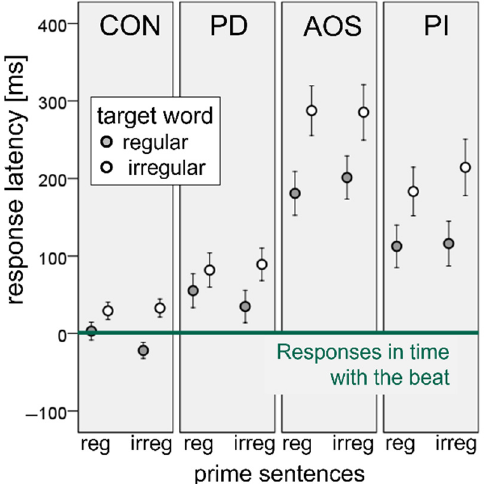
Figure 3. Normalized response latencies (in milliseconds) as a function of prime and target regularity for the healthy control speakers (CON) and the patients with Parkinson’s disease (PD), apraxia of speech (AOS), and phonological impairment (PI). Normalization was performed relative to a predicted latency of exactly the mean duration of the four metrical feet of each individual prime sentence (=0). Error bars are 95% confidence intervals, as in Figure 2.